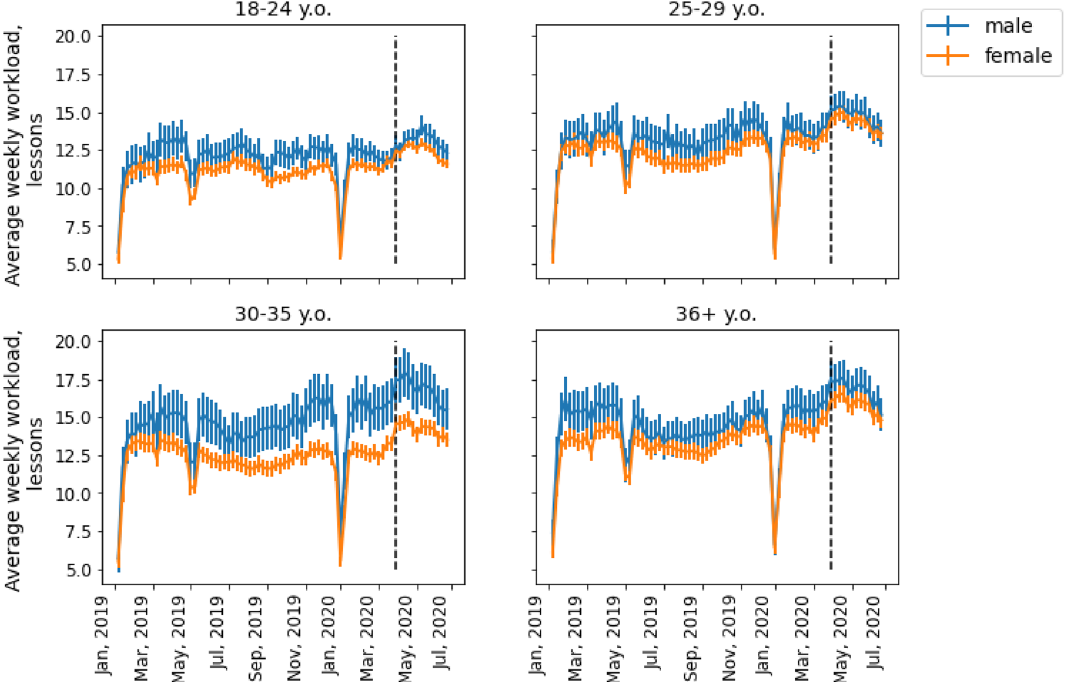
Figure 2. Average weekly teaching workload over 74 weeks, from January 1, 2019, to July 1, 2020, for four age categories. Vertical bars correspond to 95% confidence intervals. The black dashed line corresponds to the